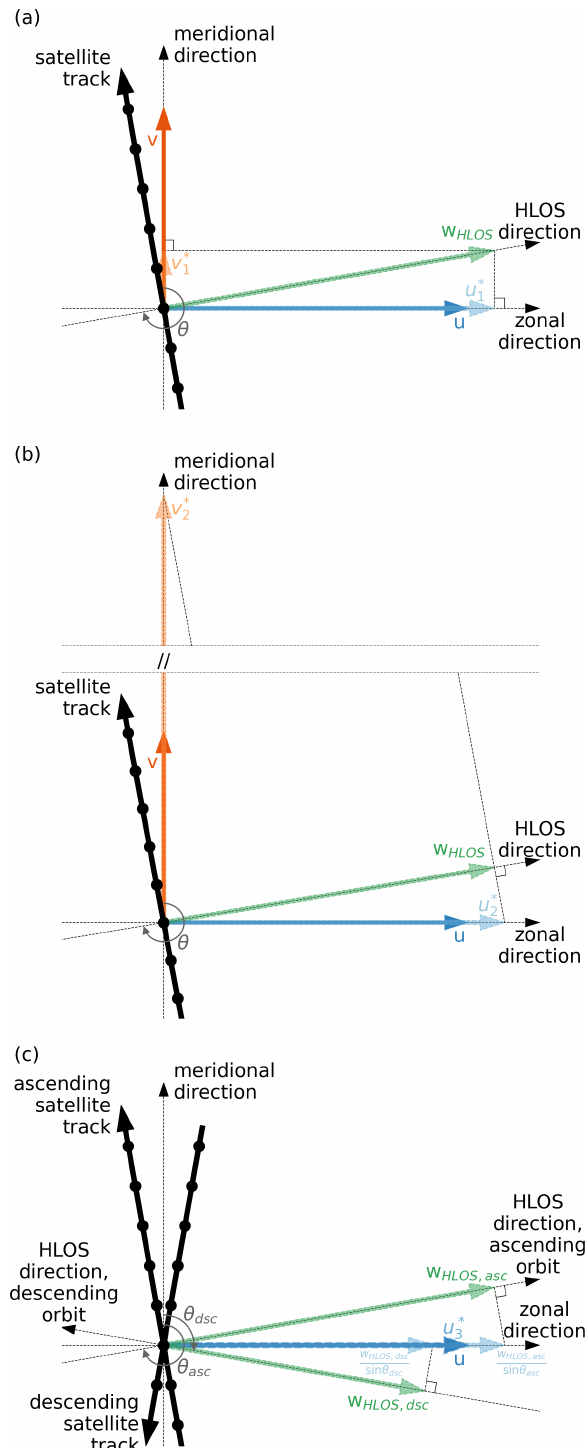
Figure 2. Geometric concepts of the three methods to convert Ae- olus w HLOS to zonal and meridional wind, which are introduced in this paper. Panel (a) shows the projection of w HLOS onto zonal and meridional axes (Method 1), panel (b) the assumption of zero zonal or meridional wind (Method 2), and panel (c) the combination of ascending and descending measurements (Method